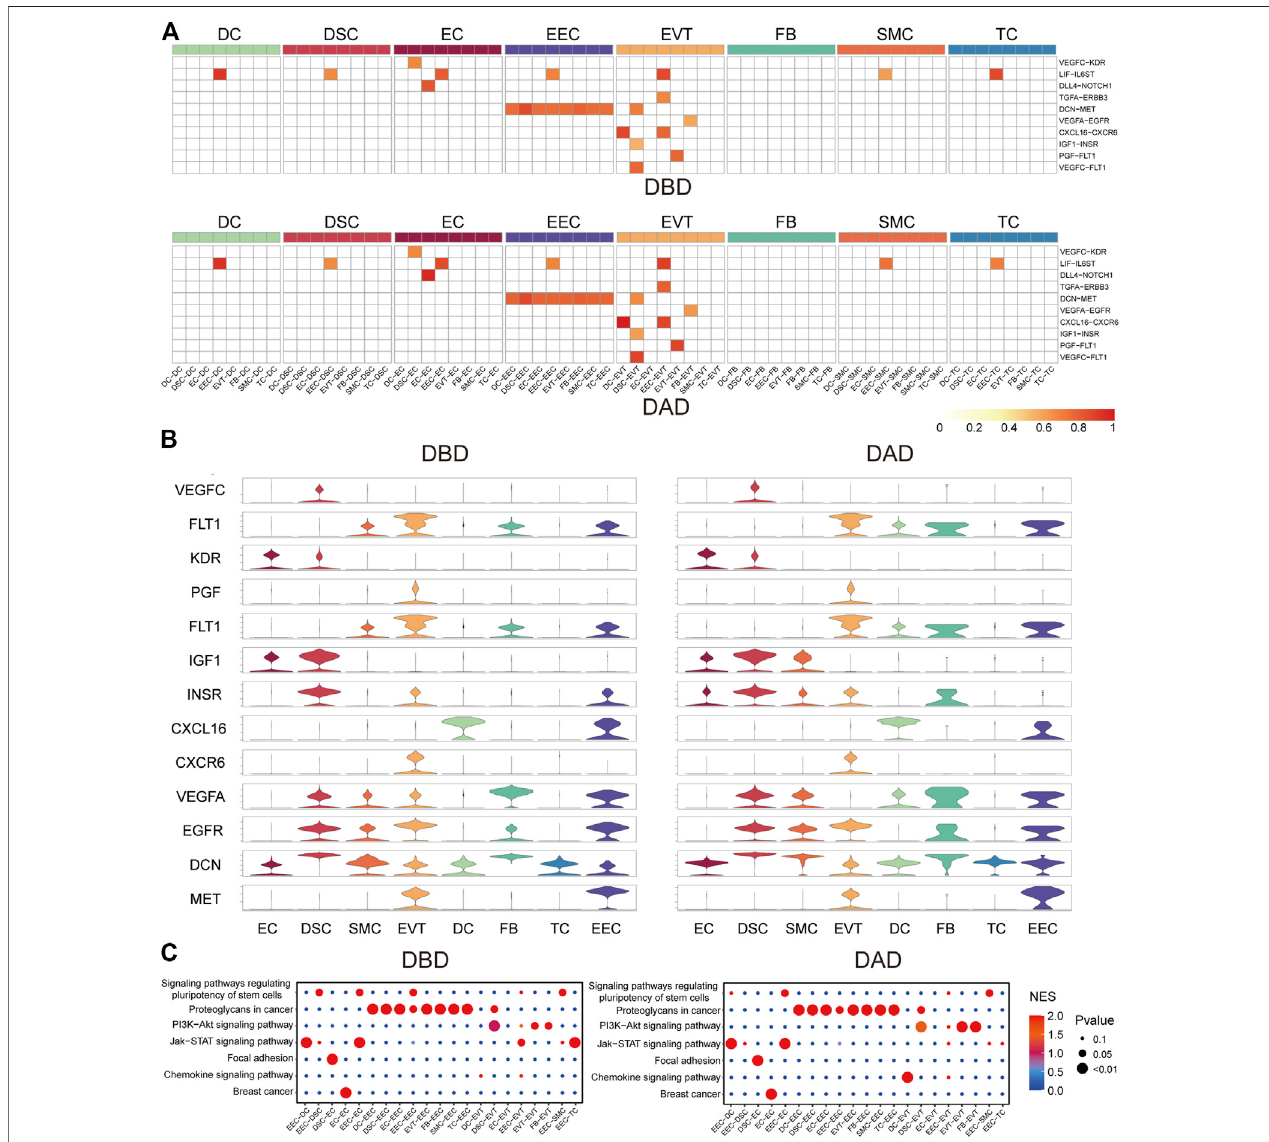
FIGURE 2 | Common forms of intercellular communications in DBD and DAD. (A) Heatmap of common intercellular signals among different cell types in DBD and DAD; red represents the score of intercellular communication. (B) Expression of ligands and receptors of common intercellular signals. (C) Pathway activity analysis of common intercellular communication in DBD and